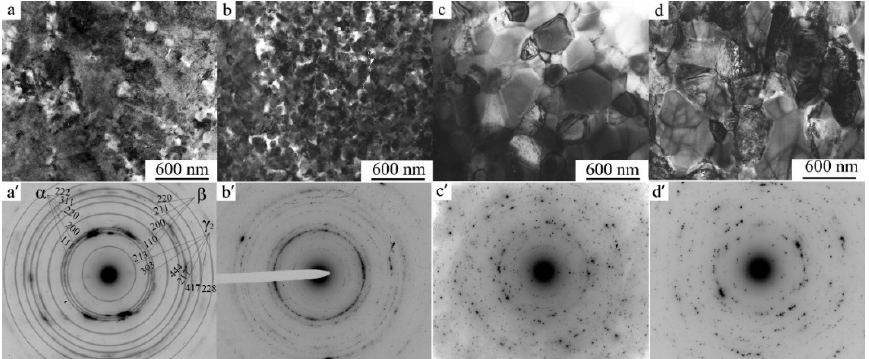
Figure 30. ( a – d ) Bright-field TEM images of microstructure and ( a ’– d ’) corresponding SAED patterns of the Cu-14Al-3Ni alloy after the HPT of 10 revs and isochronous anneals (for 30 min) at temperatures of: ( a , a’ ) 573 K, ( b , b’ ) 673 K, ( c , c’ ) 773 K, and ( d , d’ ) 873 K [46].